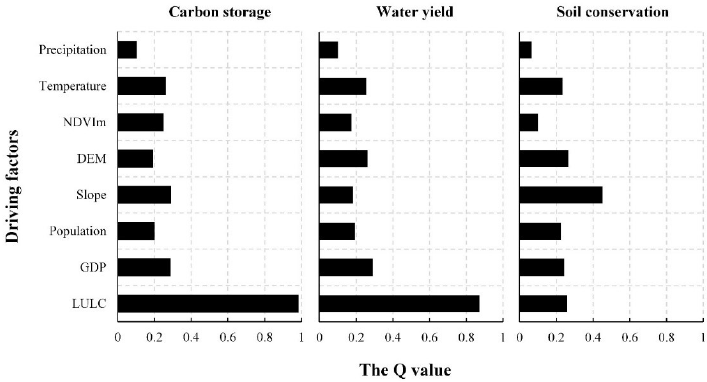
Figure 5. The impact of various driving factors on changes in ESs.